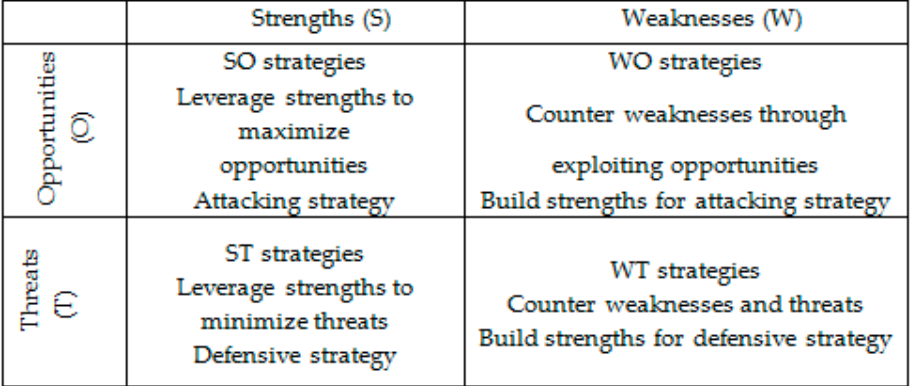
Table 1. SWOT analysis—innovative behaviour of contractor firms providing services in the Slovak forestry sector.